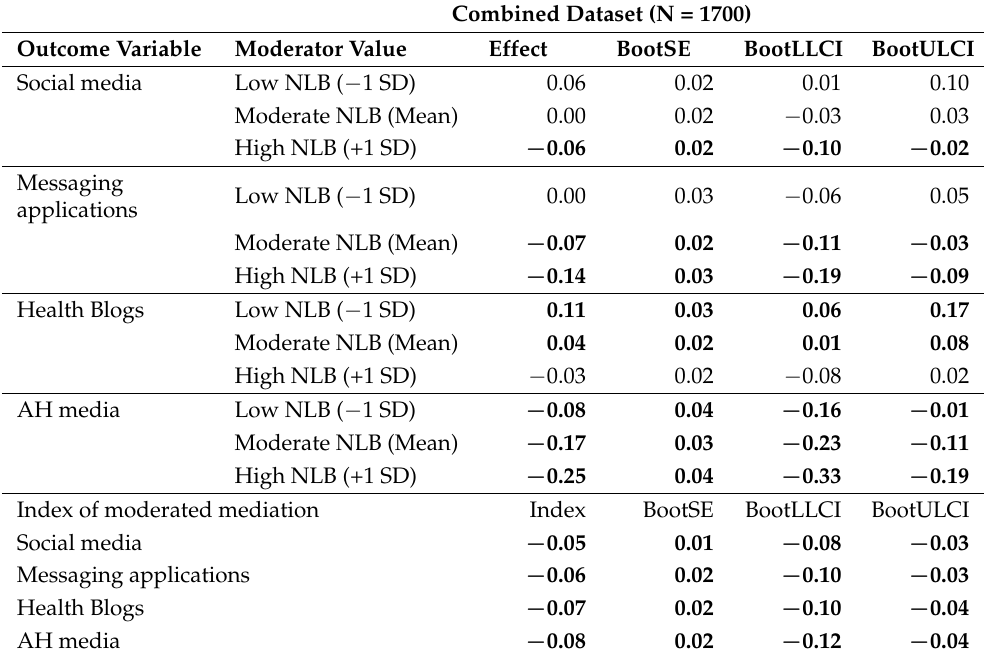
Table A10. The moderated mediation effect of media reliance for COVID-19 news on vaccination behavior (adding “reliance on health